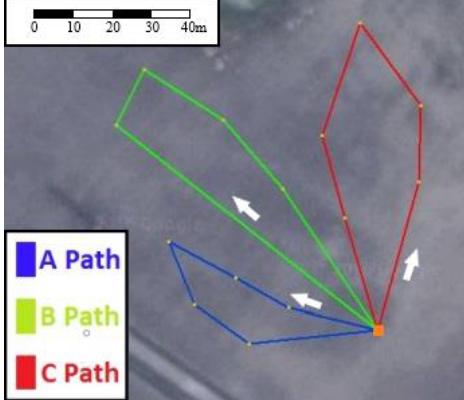
Figure 13. Shortest Total Distance Path When the Maximum Distance Limit Is 164 m.